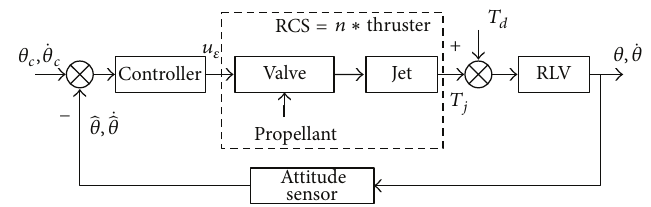
Figure 1: Block diagram of RCS.